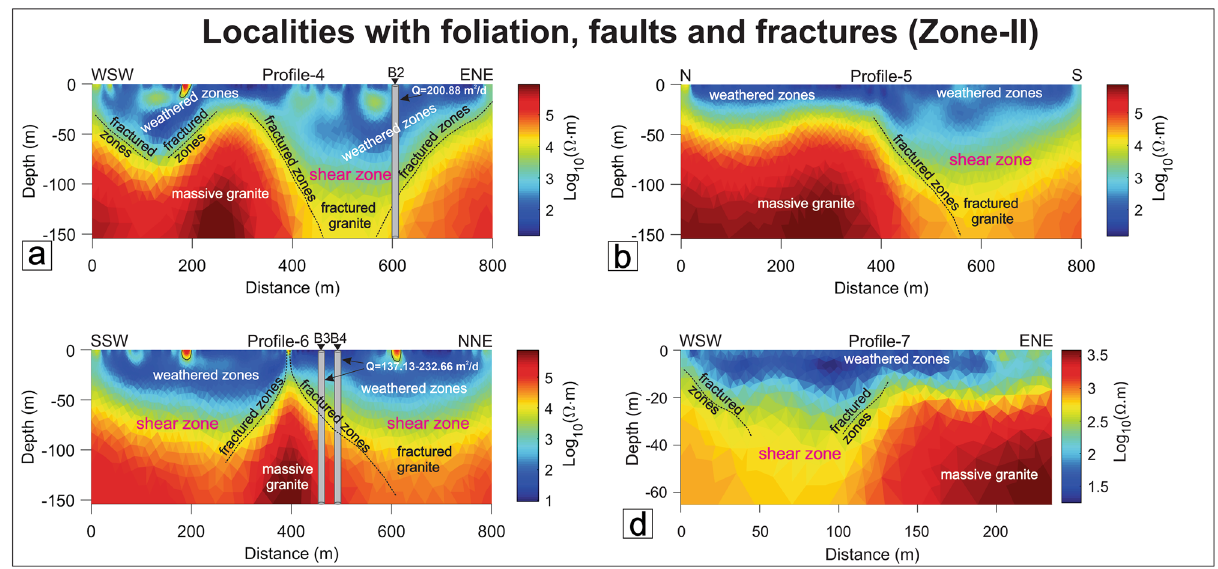
Figure 14. Resistivity profiles in Zone-II. ( a ) Profile-4, Kengora area, ( b ) Profile-5, Ghoda area, ( c ) Profile-6, Ajapur Mota area, ( d ) Profile-7, Ajapur Mota area. B2, B3, and B4 represent the borehole locations and their respective discharge rates (Q) in the Kengora and Ajapur Mota